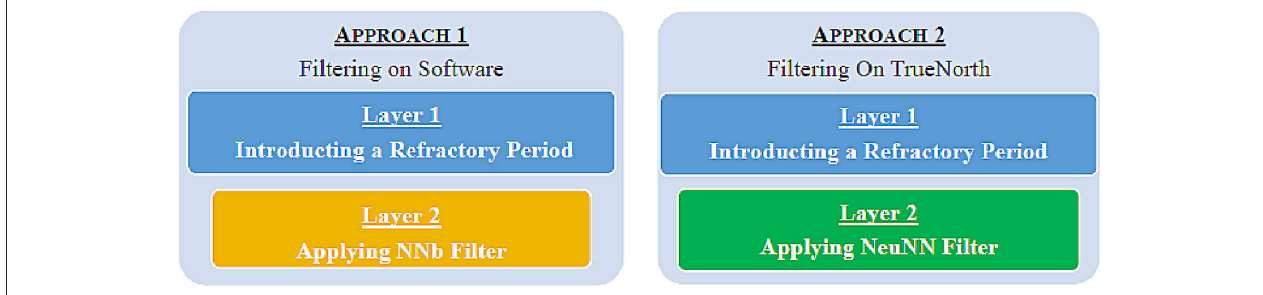
FIGURE 3 | Two layer filtering approaches in software and TrueNorth. The first layer introduces refractoriness and reduces the firing rate of repeatedly firing pixels while the second layer eliminates random noise as they do not have sufficient spatio-temporal support.